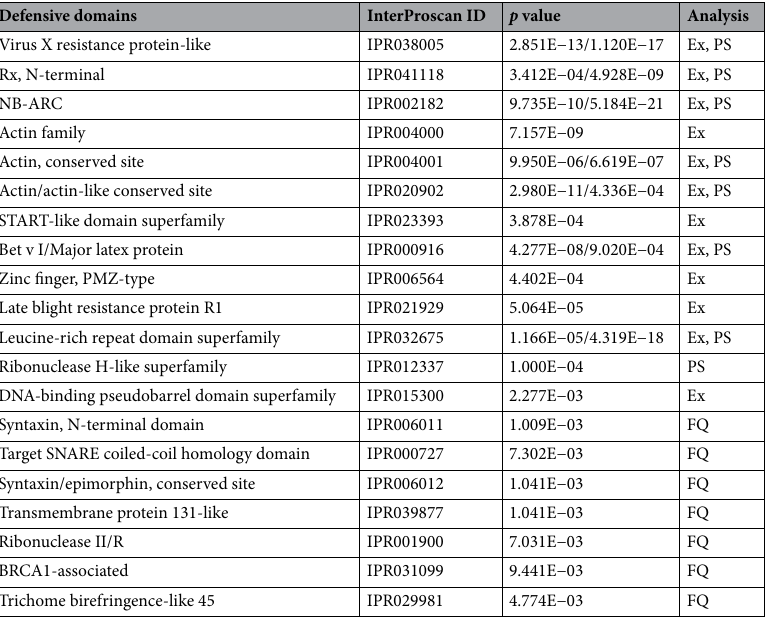
Table 2. Classifications of domains related with defence against natural enemies (pathogens, viruses, fungi, oomycete, herbivores) subject to expansion, positive selection or physicochemical divergence. Some domains were detected to be expanded and positively selected. p value is showed for each analysis. The entire list for each analysis is showed in Supplementary Tables S9, S10 and S11. Ex expanded, PS positive selected, FQ physicochemical